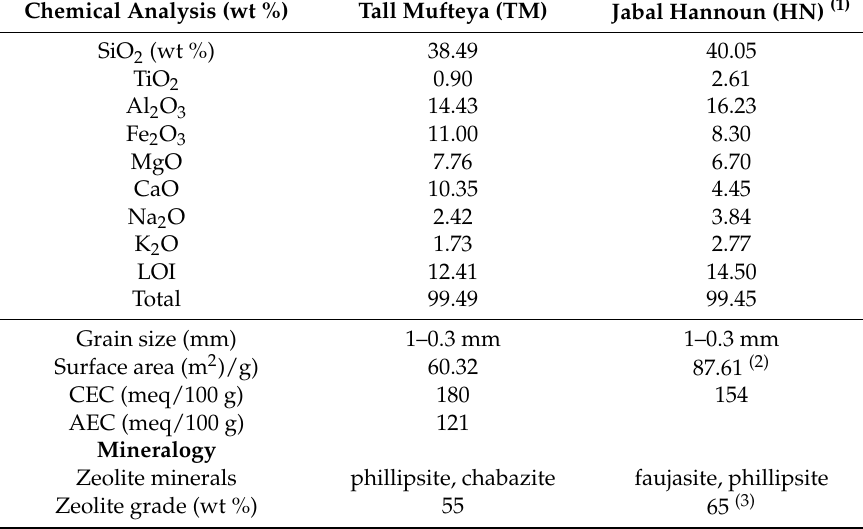
Table 1. Chemical composition and other parameters of the studied zeolitic